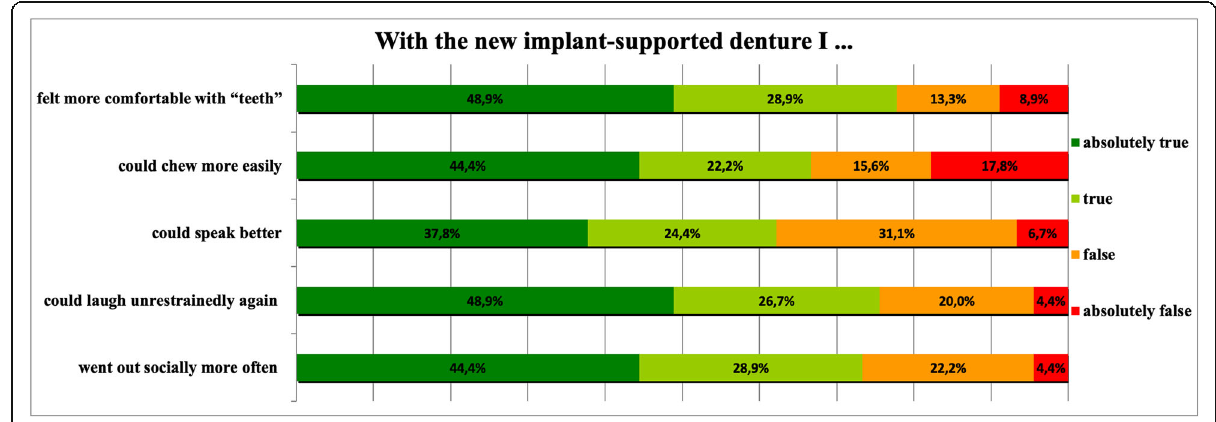
Fig. 3 Responses to pre-worded statements after Mueller et al. [7] concerning changes in life effected by implant-supported prostheses (n = 165